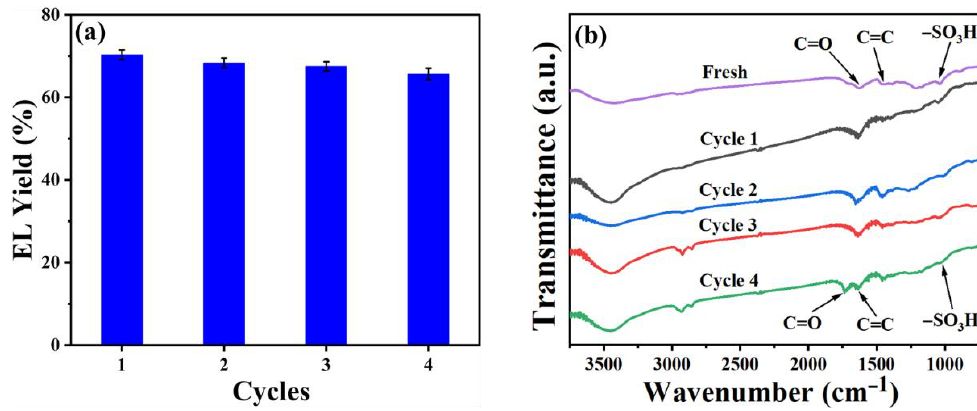
Figure 9. ( a ) Reusability study of TPC – S, and ( b ) FT-IR spectra of fresh and recycled TPC – S.